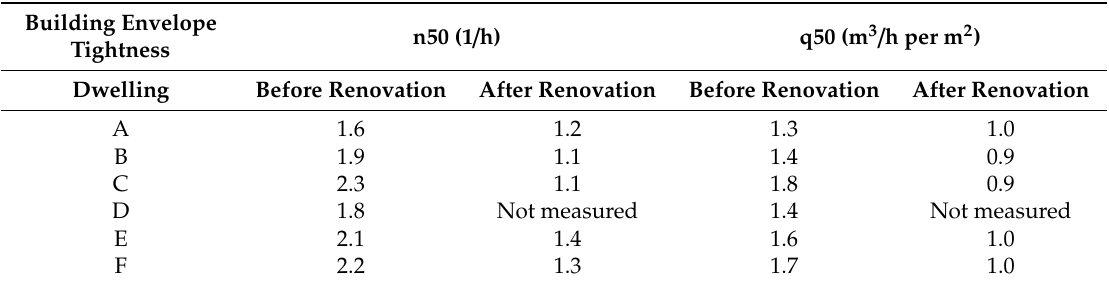
Table 3. The measurements of the building envelope tightness before and after the